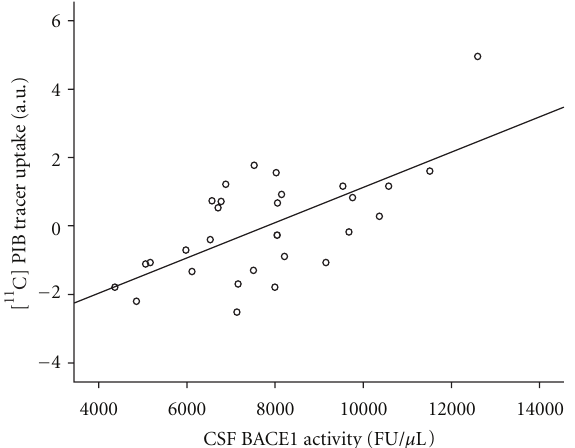
Figure 2: Linear regression analysis of fitted and adjusted [ 11 C]PIB uptake and CSF BACE1 activity at the localization of the most significant cluster (Talairach’s coordinates x/y/z 18 / − 24 / − 9, right parahippocampal gyrus, Brodmann’s area 35), FU: fluorescence